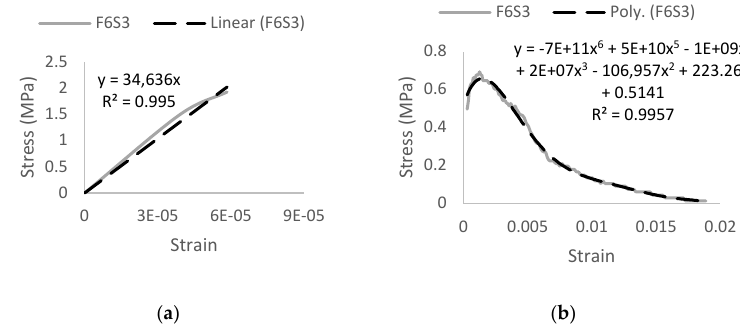
Figure 9. F6S3 uniaxial tension stress – strain curve: ( a ) elastic stage and ( b ) plastic stage. Table 9. Material properties of F6S3 HyFRC.